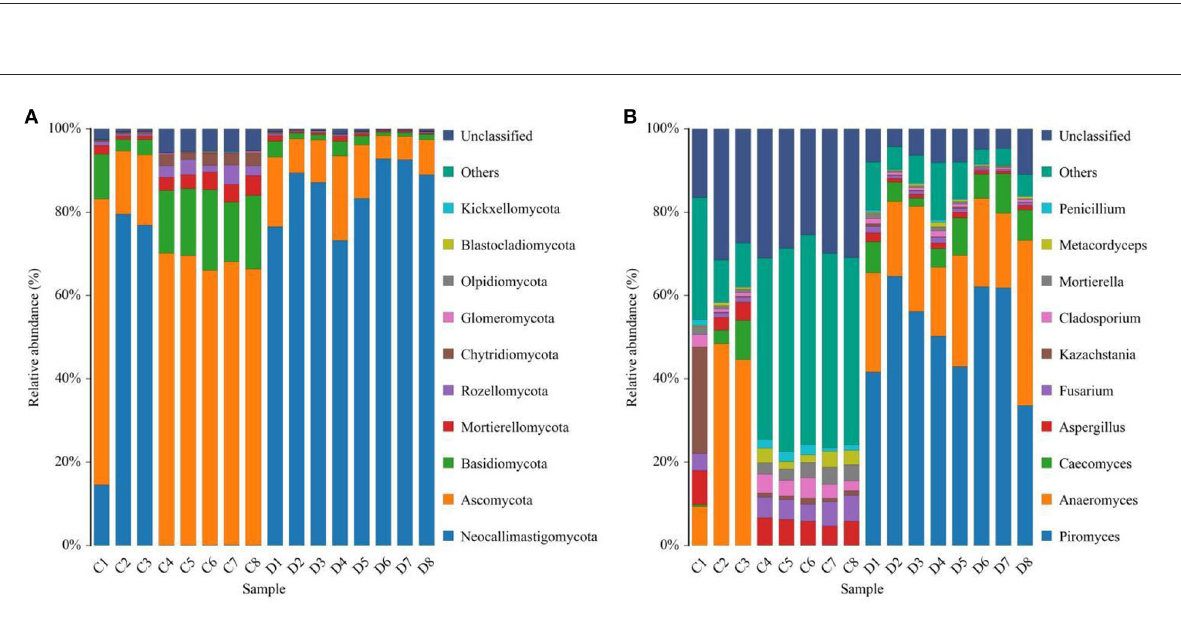
FrontiersinVeterinaryScience